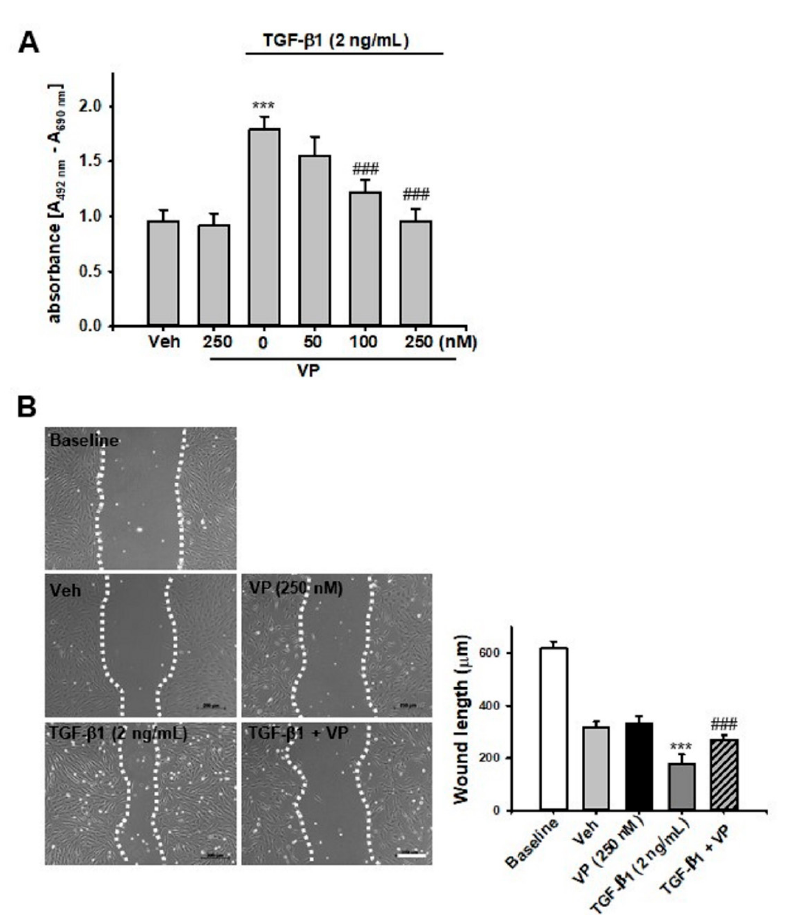
Figure 5. Effect of verteporfin on TGF-ß1-induced fibroblast proliferation and cell migration in NRK-